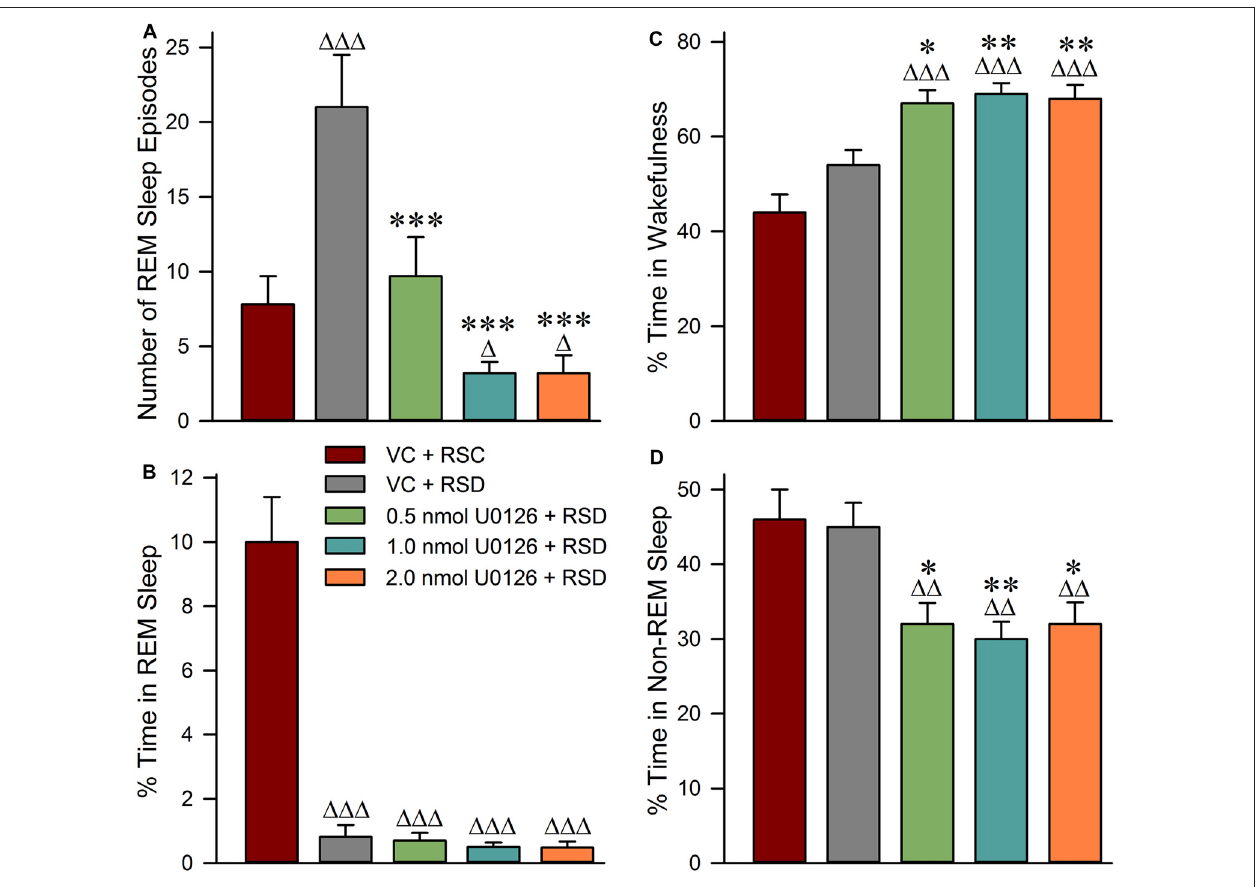
FIGURE 3 | Application of U0126 into the PPT suppresses selective REM sleep deprivation-induced REM sleep homeostatic pressure. This effect was observed during the 3-h sleep-wake recording session that immediately followed bilateral microinjections of U0126. (A) Bars represent number (mean ± SE) of REM sleep episodes. (B) Bars represent total percentages of time (mean ± SE) spent in REM sleep. (C) Bars represent percentages of time spent in wakefulness. (D) Bars represent percentages of time spent in NR. Post hoc tests (Bonferroni’s multiple comparisons test): triangle represents the comparison with vehicle control + REM sleep control (VC + RSC) and asterisk represents the comparison with vehicle control + selective REM sleep deprivation (VC + RSD). ∆ p < 0.05; ∆∆∆ or ∗∗∗ p <